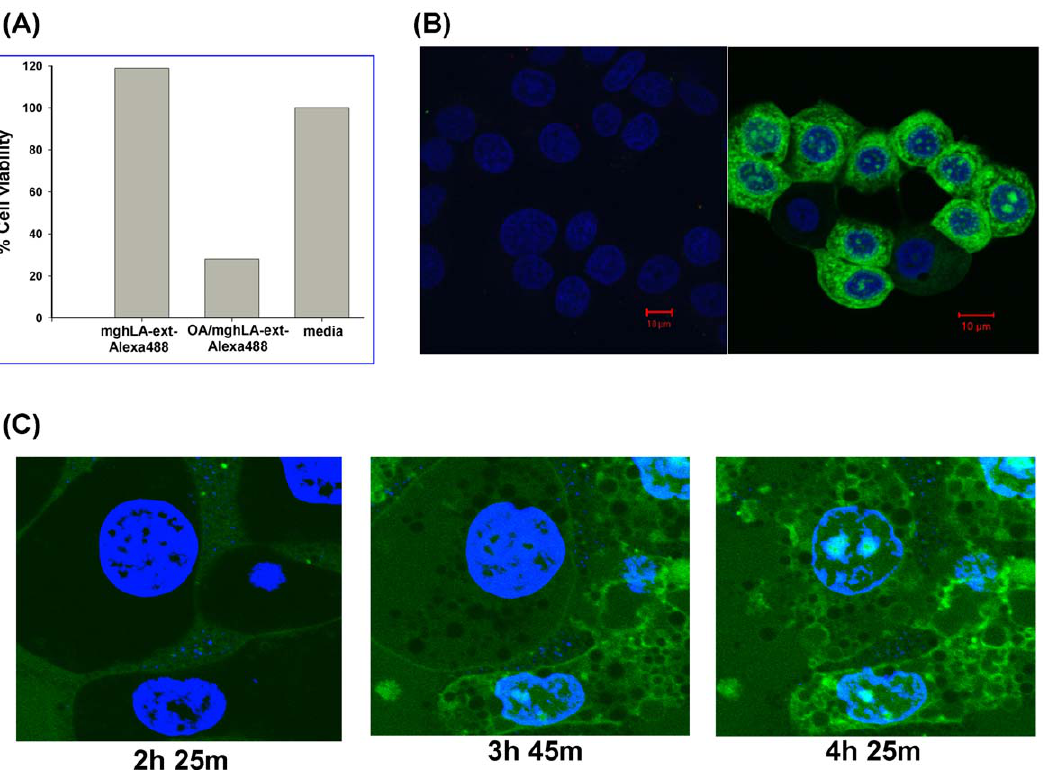
Figure 8. Microscopy studies using site-specific-fluoroprobe-labeled protein. (A) Tumoricidal activity of the labeled protein hLA-ext in molten globule state was tested on A549 cells. MCF-7 cells were incubated for 4 h, with 30 m M Alexa Fluor 488-labeled mg-hLA-ext protein alone (B) or complexed with OA (C). After treatment, cells were fixed and nuclei were stained with vital stain Hoechst 33342 (blue). When complexed with OA, Alexa Fluor 488 labeled mg-hLA-ext (green) internalizes to cytoplasm and cell nuclei, while molten globule protein alone did not enter the cells. (D) Confocal images of SK-BR-3 cells treated with Alexa Fluor 4888-labeled mghLA-ext complexed with OA at the indicated times.